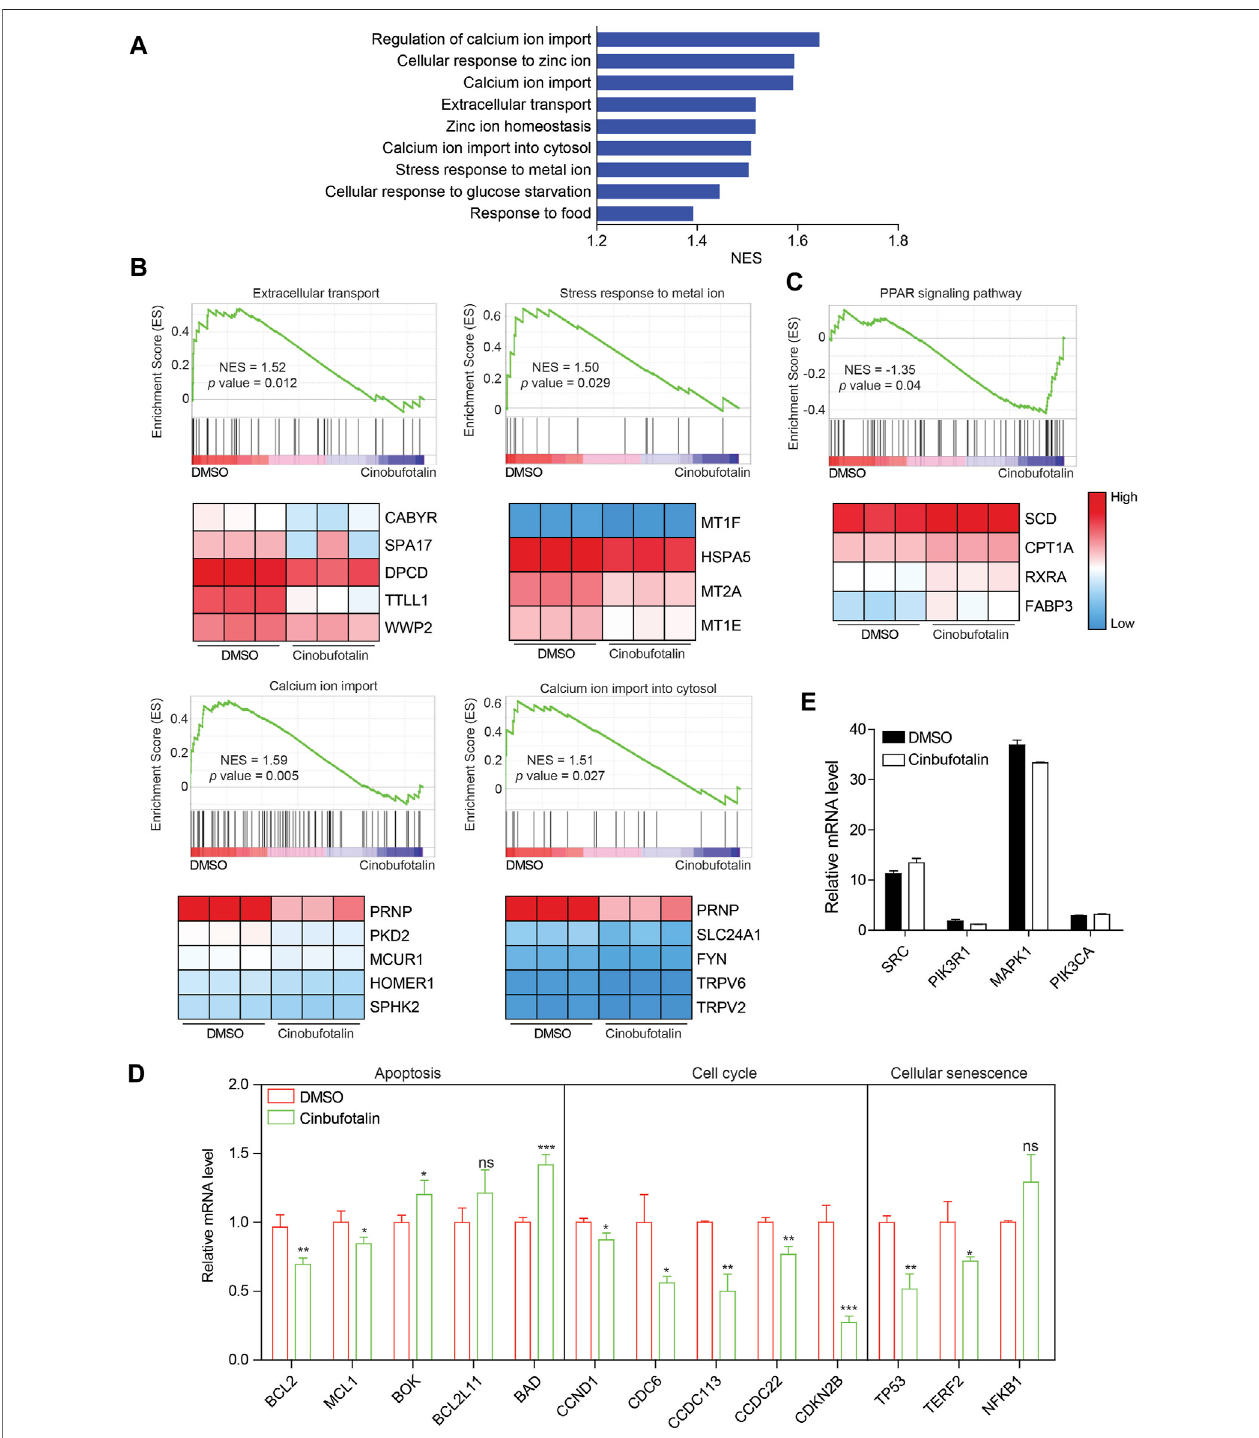
FIGURE 5 | Cinobufotalin inhibits the extracellular signal response of tumor cells (A) The core-enriched signaling pathways in cinobufotalin treatment or control groups.NES,normalizedenrichmentscore (B,C) GSEApathwayenrichmentanalysesofHCT8cellswiththetreatmentofcinobufotalin.Geneswithsigni fi cantlydifferent expression are shown as heat maps (D) The expression of apoptosis, cell cycle and cellular senescence related genes in HCT8 cells with the treatment of cinobufotalin (E) The expression of hub genes in HCT8 cells with the treatment of cinobufotalin. Error bars represent mean values ±SD from three replicates of each sample (ns: p > 0.05; *: 0.01 < p < 0.05; **: 0.001 < p < 0.01; ***: p < 0.001).